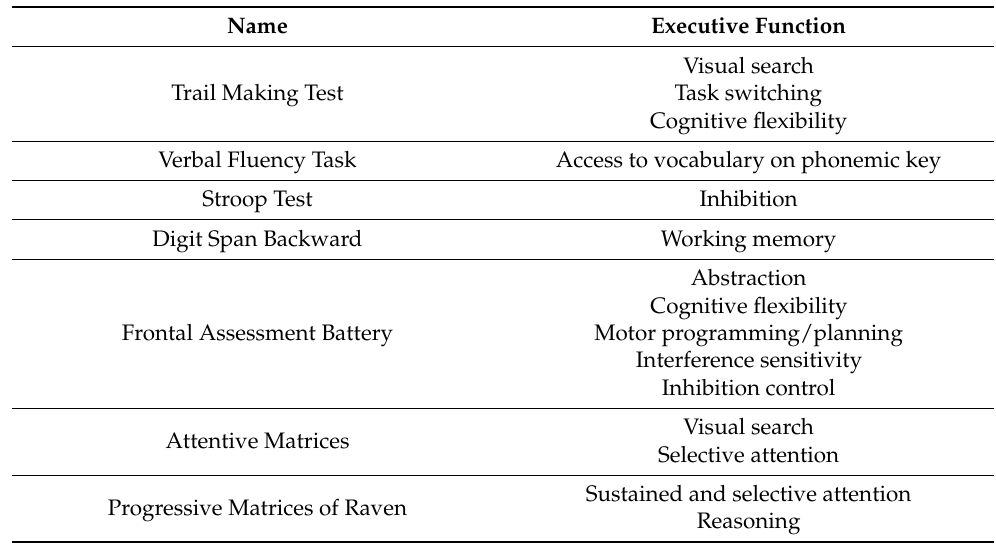
Table 1. Pre-task evaluation: Neuropsychological